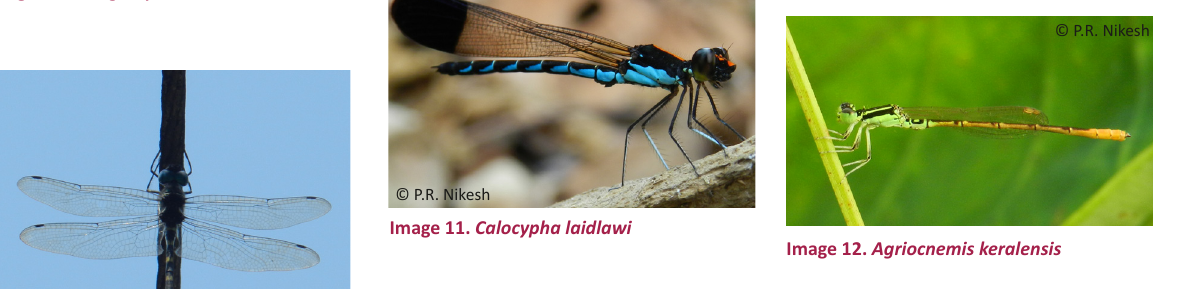
Image 7. Microgomphus souteri